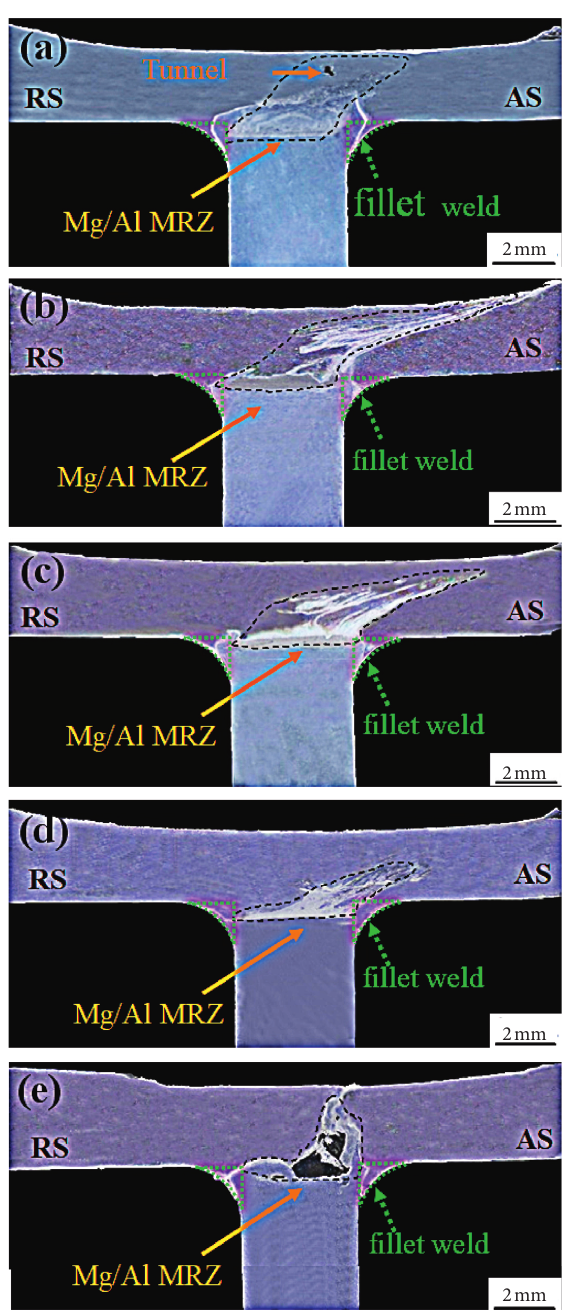
Figure 8: Cross section of T-joint: (a) 15mm/min; (b) 30mm/min; (c) 50mm/min; (d) 65 mm/min; (e)